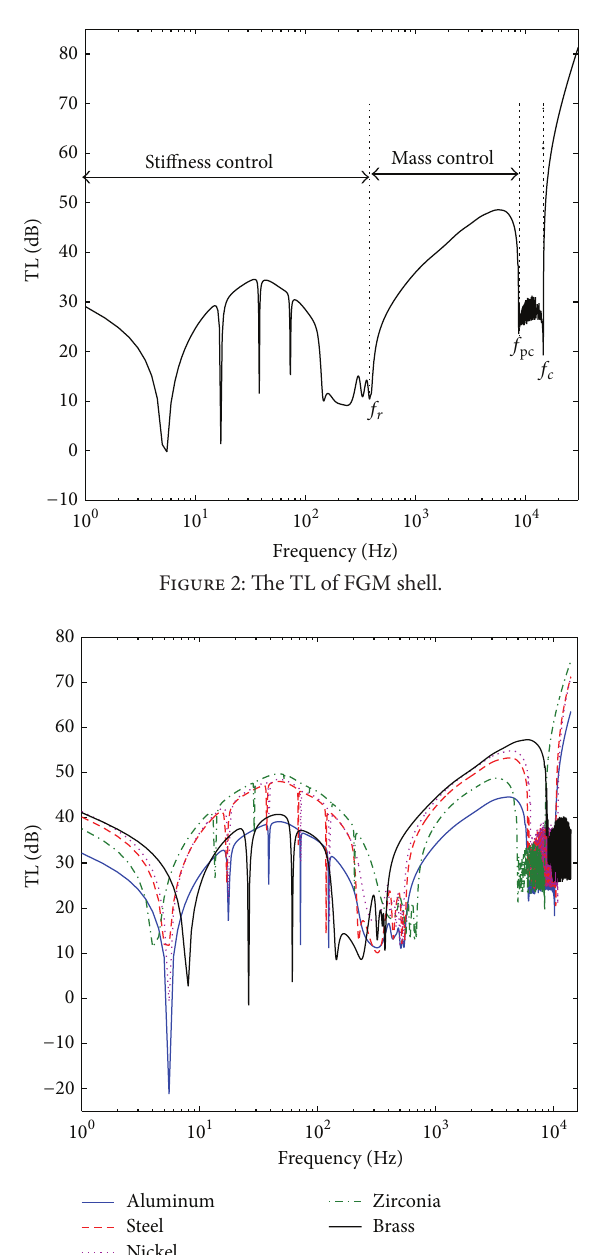
Figure 3: Effect of different materials on